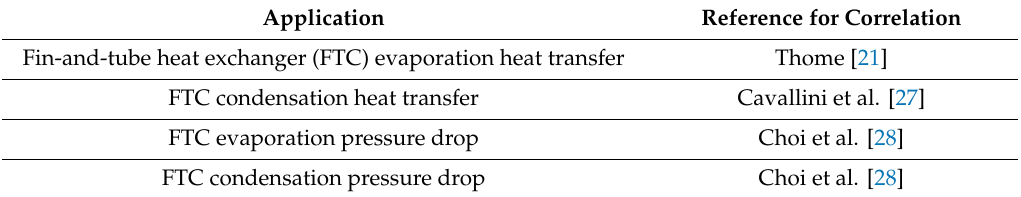
Table 2. Selected references describing correlations for two-phase heat transfer and pressure